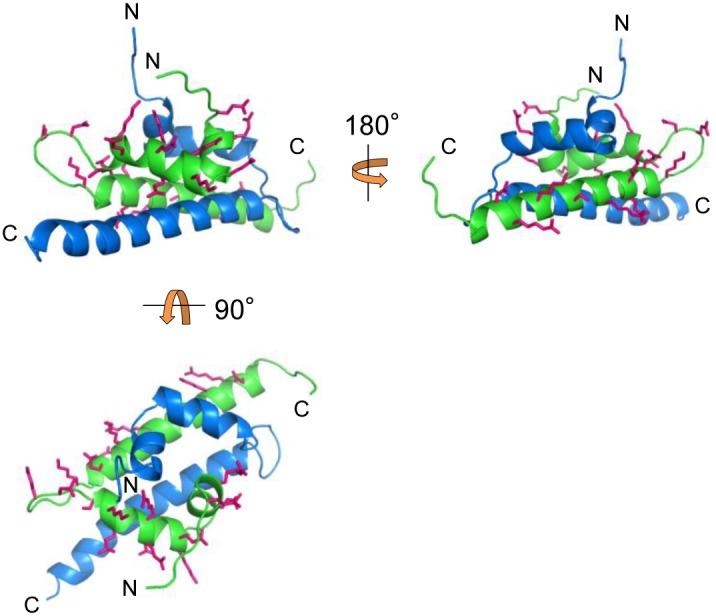
Ribbon representation of the structural model of the Pmr_nt61 dimer.The two protomers are displayed in green and blue. On the green protomer, side chains of the 22 residues predicted to be important for homo-oligomerization are shown in magenta. The N- and C-terminus of the two protomers are shown as “N” and “C”, respectively.